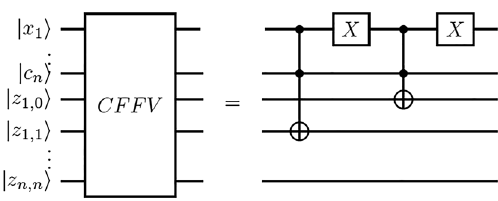
Figure 7. Quantum circuit for the CFFV